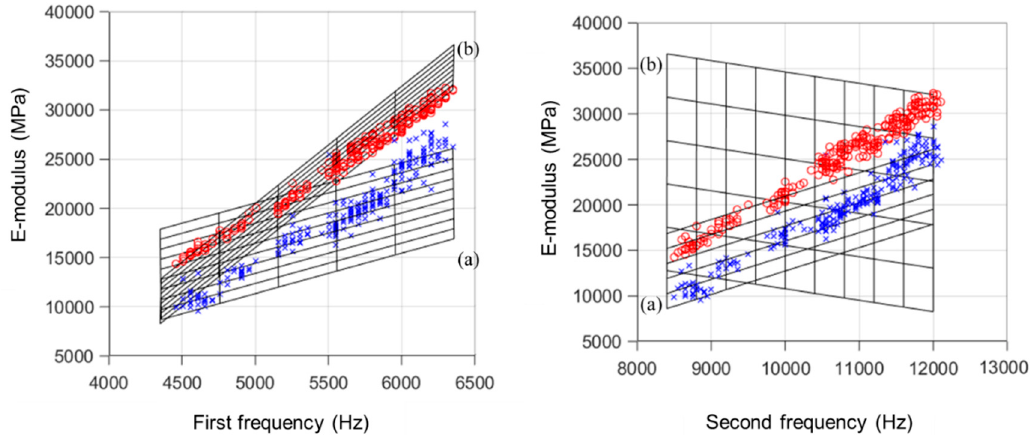
Figure 11. Comparison of prediction results with two frequencies. ( a ) Predicted Ei with multiple linear regression (MLR), ( b ) Predicted Ed with Equation (4).